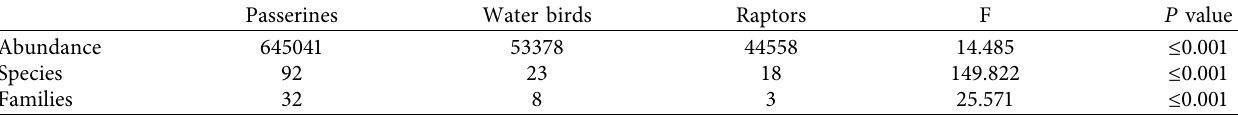
Table 4: Comparison of the bird’ groups recorded in Midelt province with ANOVA one-way test.